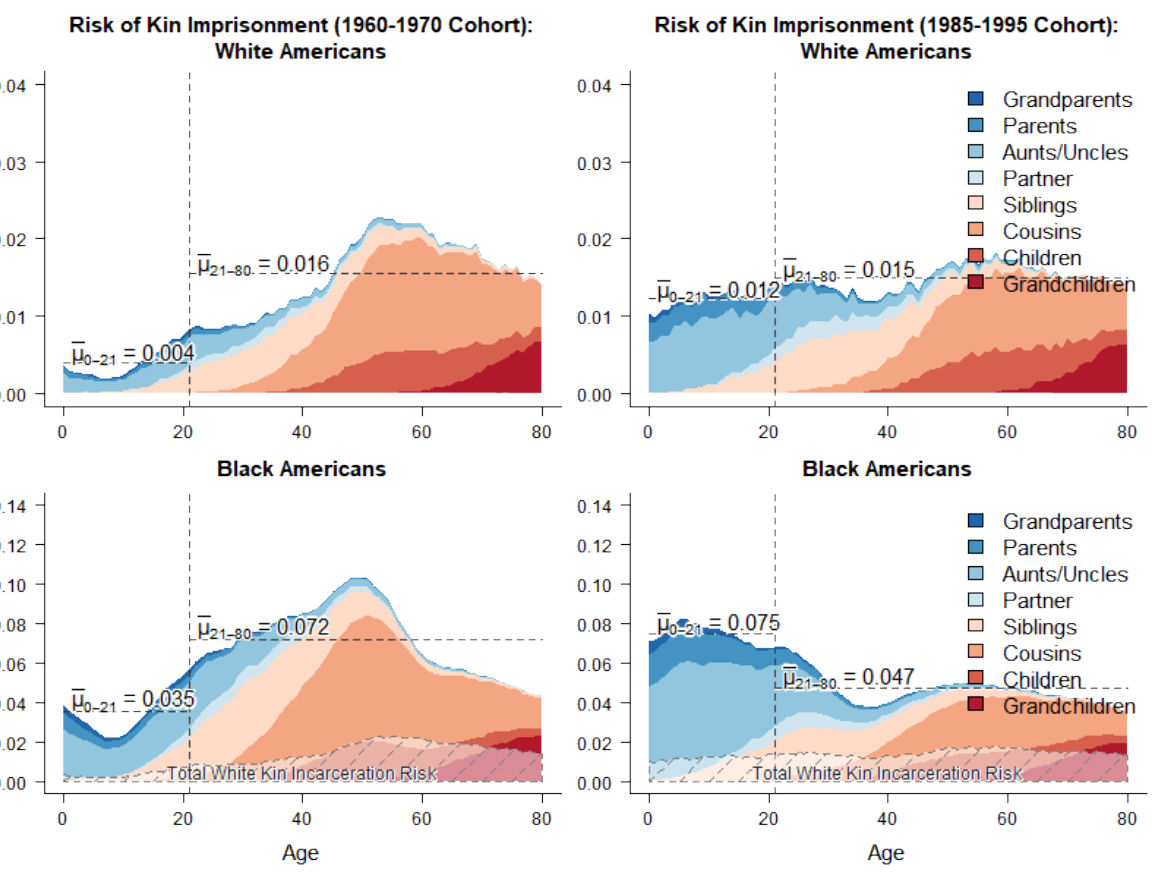
Figure 1: Cohort-specific probabilities of first kin incarceration over age (by relation). The top plots illustrate the contributions of each kin relation to the overall risk profile for white individuals; the bottom plots illustrate the same for black individuals. Horizontal dashed lines indicate mean overall risk before and after age 21 (which is indicated with the vertical dashed line). The total risk density of the white population is superimposed on the bottom (black population) plots to aid comparison across the two different y axis